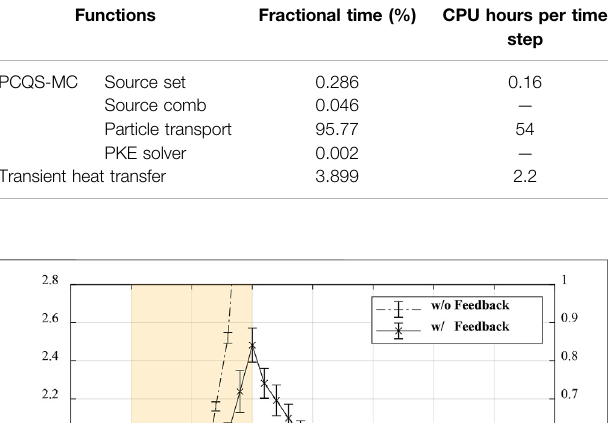
Figure 4 . The CSBA model used in this simulation is described in Table 1 , and material properties used in the analysis are identical to those in the study by Kim and Kim (2020).